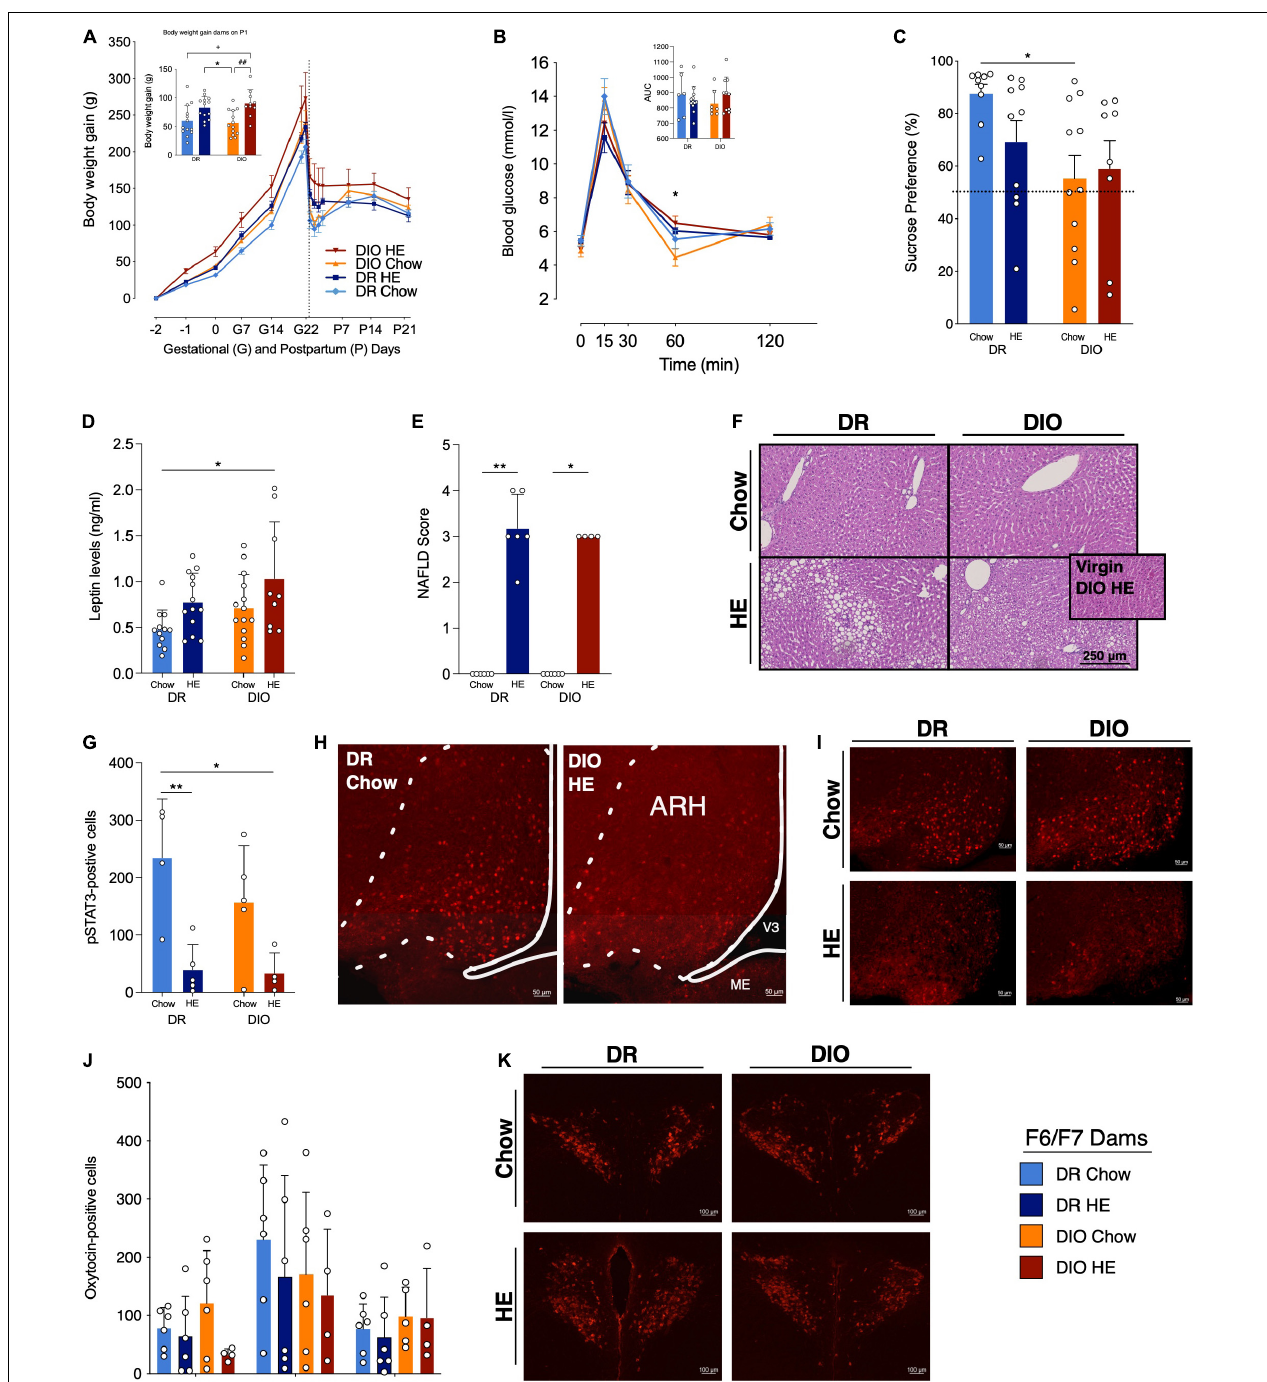
FIGURE 6 | Influence of HE-diet in diet resistant (DR) and diet induced obese (DIO) rat dams in filial generation 6 and 7 (F6/F7) on selected physiological parameters. (A) Body weight gain in gram (g) of DR dams on chow (light blue) or HE diet (dark blue), and DIO dams on chow (orange) or HE diet (red) during pregnancy and lactation. Dotted vertical line marks parturition. Inset shows body weight gain during pregnancy (difference between body weight on G1 and P2). (B) Blood glucose levels (mmol/l) during an oral glucose tolerance test in DR and DIO dams on chow or HE diet. Inset shows the area under the curve (AUC) relative to zero. (C) Sucrose preference in percent of total liquid intake on P14–15 in DR and DIO rat dams on either chow or HE diet. (D) Plasma leptin levels in ng/ml in fasted DR and DIO dams on chow or HE diet on P18 ± 1. (E) Average severity of liver steatosis according to the NAFLD scoring system for rodents (Grade 0–4) in DR and DIO dams on chow or HE diet. HE diet triggered liver steatosis regardless of phenotype. (F) Representative images of H&E sections. Inset in (F) shows image from a non-pregnant, non-lactating DIO dam after 6 weeks on HE diet (no steatosis present). (G) Quantification of pSTAT3-positive cells in the arcuate nucleus of